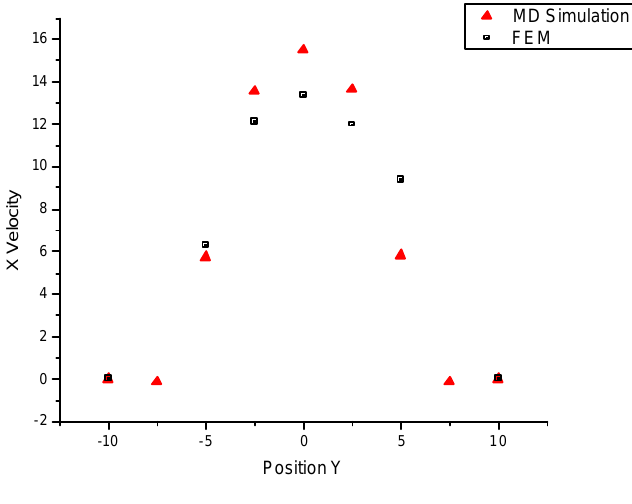
Figure 5. X velocity profile at position x=115 in Case 2